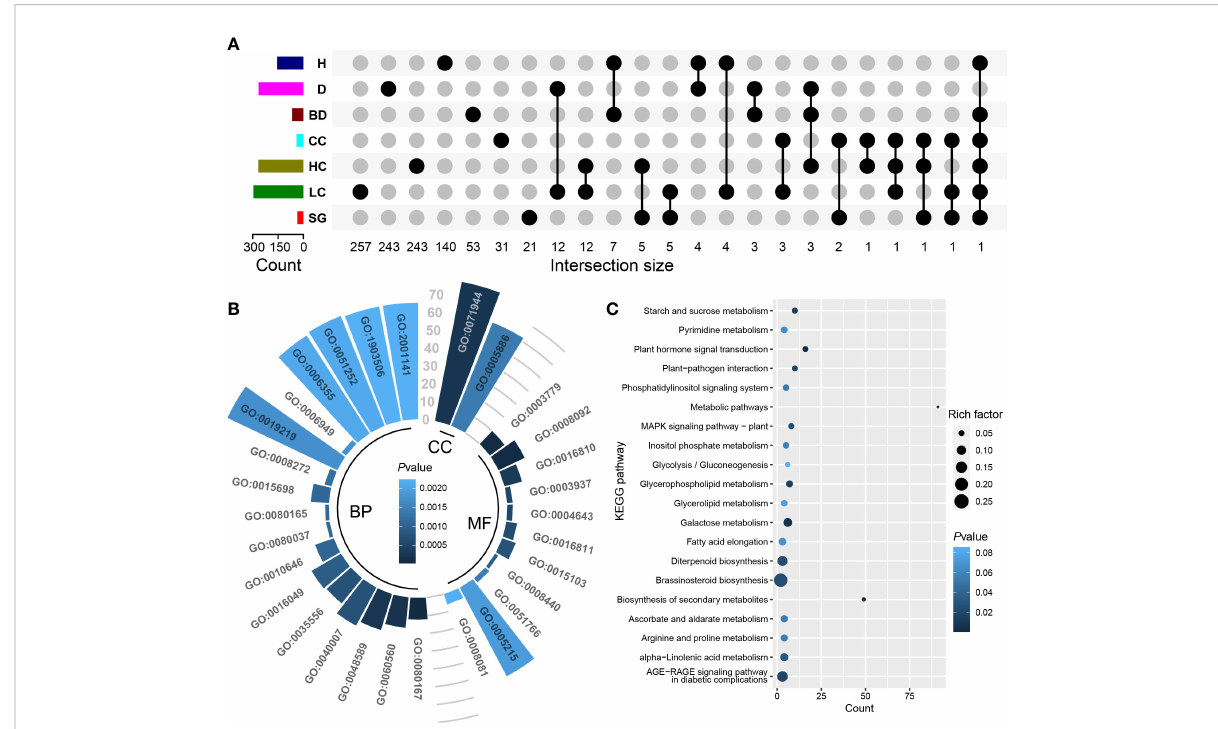
FIGURE 4 Identi fi cation and functional analysis of candidate genes for economic traits. (A) Upset plot of the intersection size of candidate genes for each trait. Connected black circles indicate the number of overlapping genes between traits, and unconnected black circles indicate the number of genes unique to a trait. (B) Top 30 most-signi fi cant GO terms from analysis of candidate genes. The length of the radial bars indicates the gene count. The CC, MF and BP are cellular component, molecular function and biological process, respectively. (C) shows the top 20 most- signi fi cant KEGG pathways. Details of GO terms and KEGG pathways are shown in Tables S10, S11,